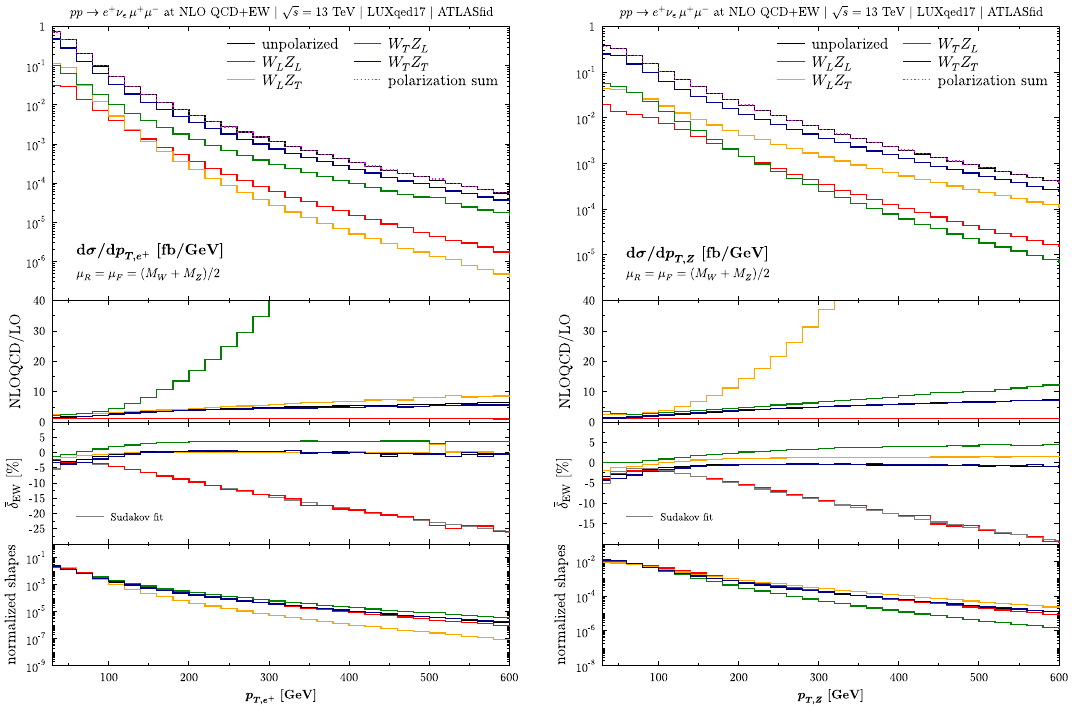
Fig. 5 Same as Fig. 3 but for the transverse momentum of the electron (left) and the Z boson (right). In the middle-down panel, the grey line is the Sudakov fit (see text) of the W